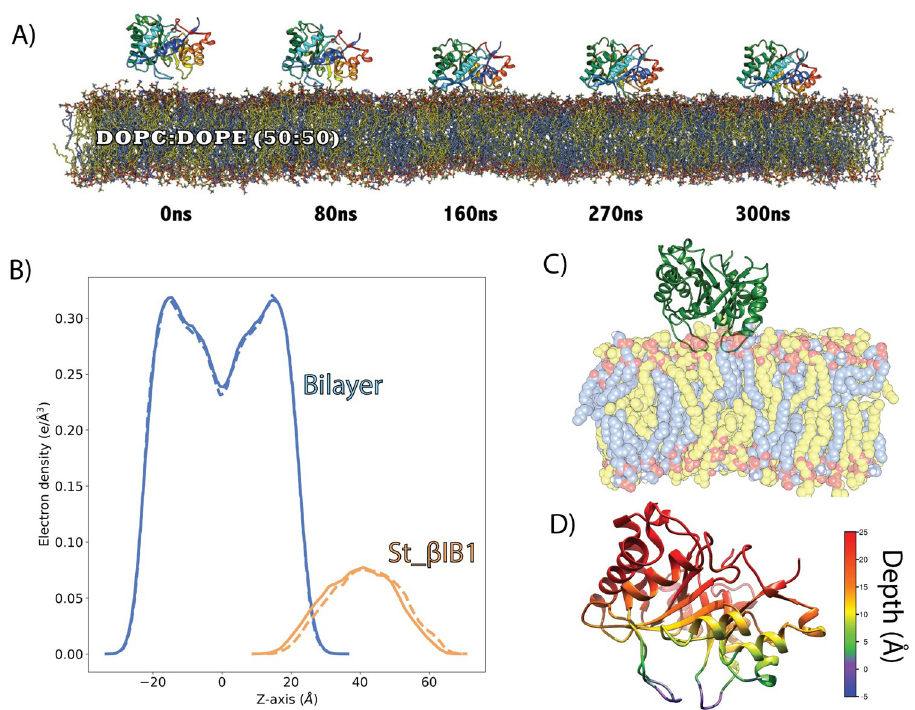
Fig 5. Binding of St_ β IB1 to a POPC:POPE (50:50) bilayer. A) Simulation snapshots. B) Electron density plot for two replica (solid lines and dashed lines). C) Bound form. D) Depth of anchorage. The depth is calculated for each amino acid as the distance between its C-alpha and the phosphate plane in the last frame of simulation (relevant values are given in Table C in S2 Text).